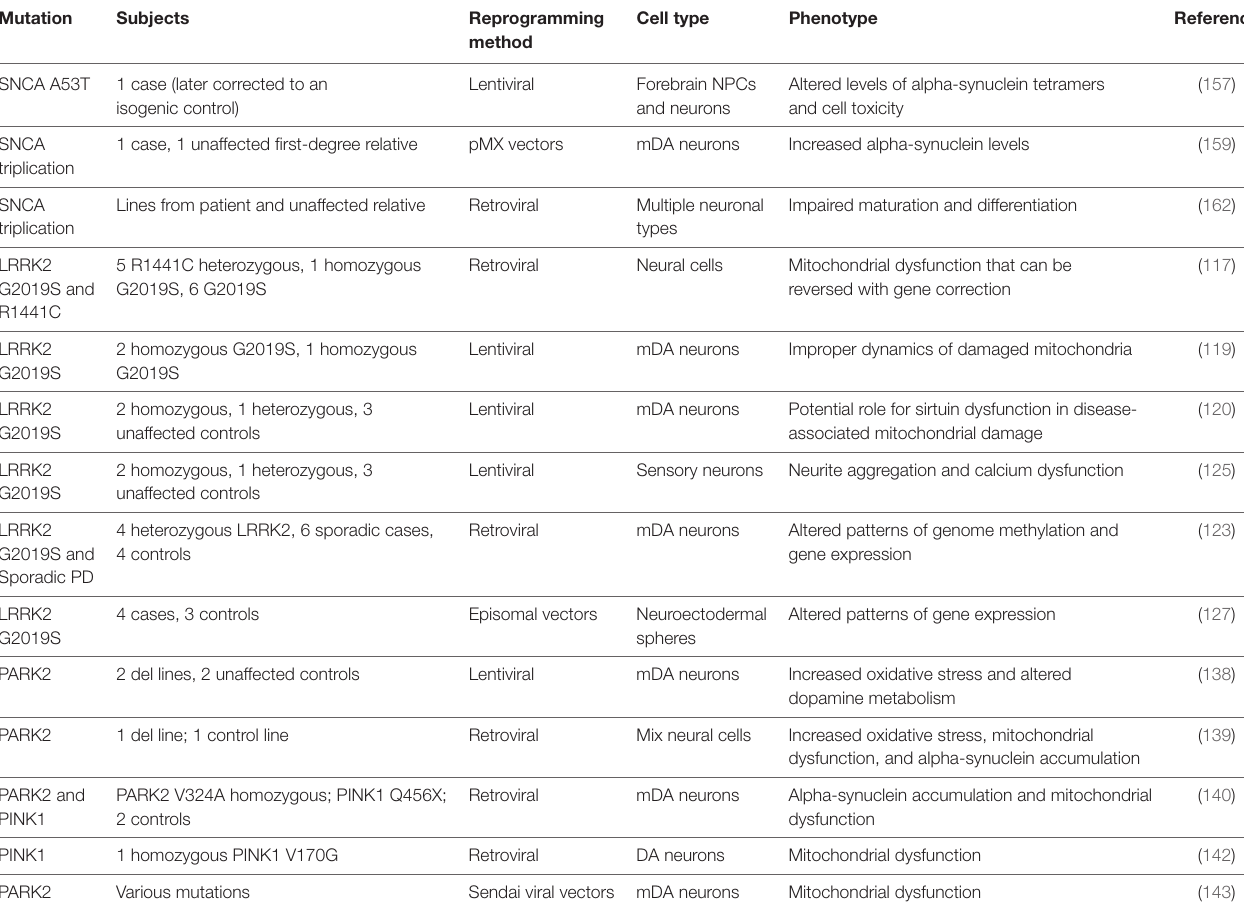
TABLe 2 | Studies of human-induced pluripotent stem cell (hiPSC) models of Parkinson’s disease (PD).